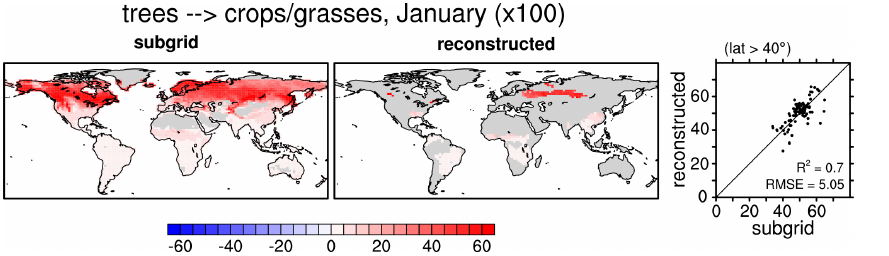
Figure 5. Same as Fig. 4, but for the month of January. The scatter plots in this case only display the results for the grid cells north of 40 ◦ (i.e. over areas considered snow-covered). Note that the scale is